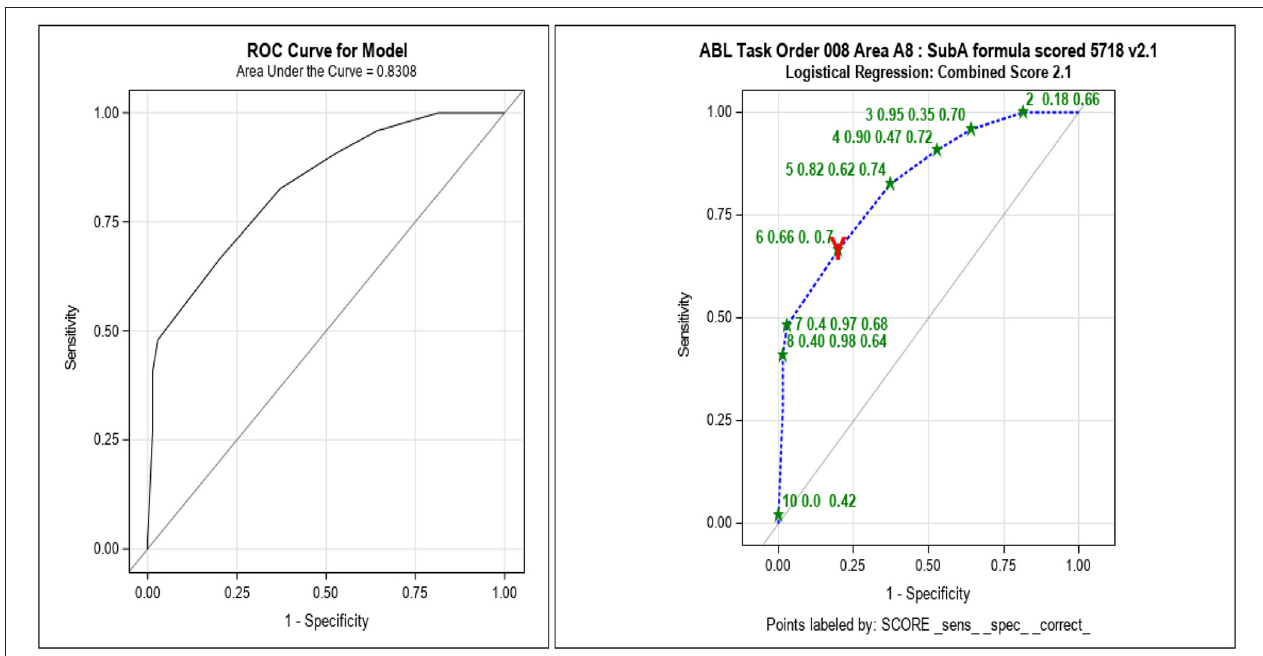
FIGURE 5 | Subsample A receiver operating curve (ROC) area under the curve (AUC) analyses with v2.1 scoring algorithm showing acceptable sensitivity and specificity. After each subsample was scored and compared with inflammation as determined by cytokine analysis, an ROC AUC was calculated to determine the optimal scoring algorithm to be used for evaluation of the next subsample (_sens_, sensitivity; _spec_, specificity; _correct, proportion correctly categorized as “inflamed” or “normal,” at each cut-off). The red Y indicates the Youden, optimized, and